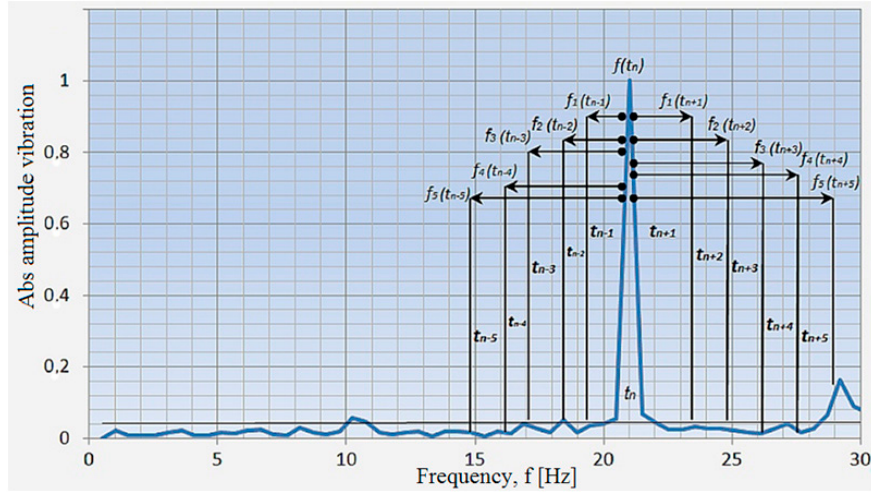
Figure 10. Interpretation of frame intervals for the analyzed amplitude spectrum.